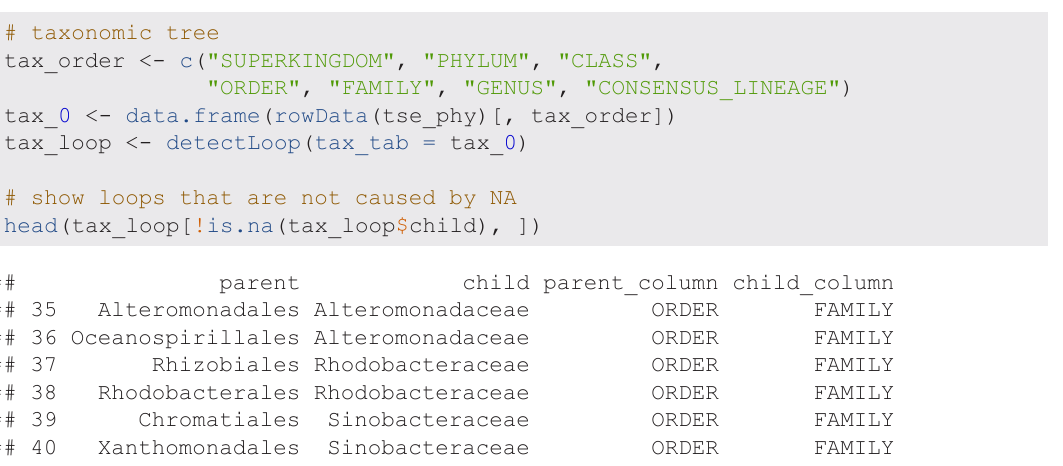
t-SNE on broader taxonomic levels To organize data at different taxonomic levels, we first replace the phylogenetic tree with the taxonomic tree that is generated from the taxonomic table. Due to the existence of polyphyletic groups, a tree structure cannot be generated. For example, the Alteromonadaceae family is from different orders: Alteromonadales and Oceanospirillales .